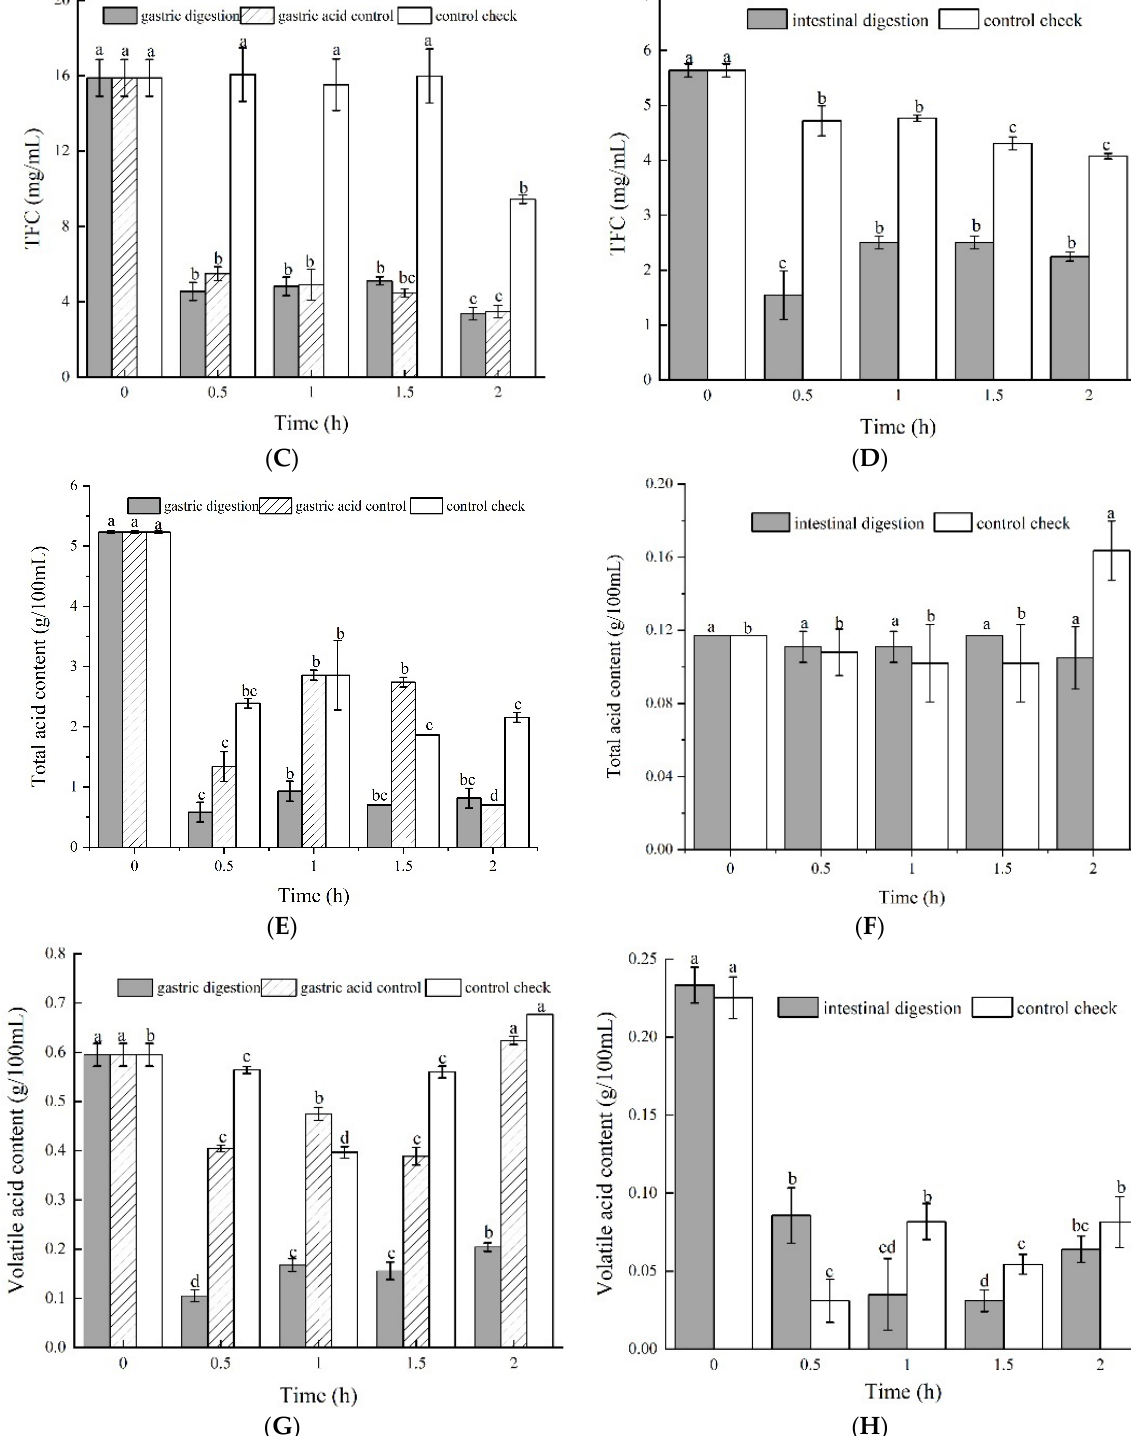
Figure 1. Antioxidants of green jujube vinegar during in vitro gastrointestinal digestion, ( A , B ) total phenolic content; ( C , D ) total flavonoid content; ( E , F ) total acid content; ( G , H ) volatile acid content.